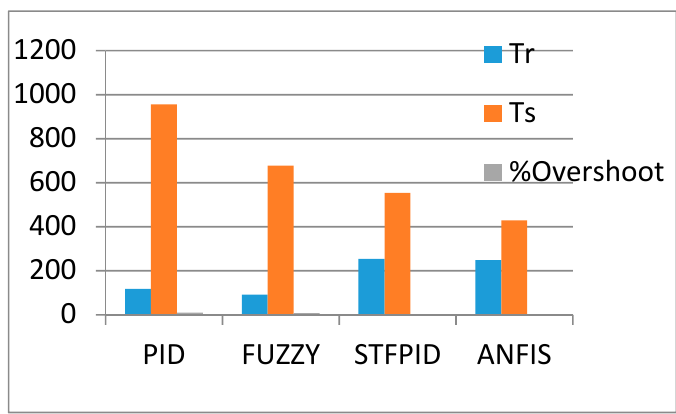
Figure 24. Bar chart of the heading plane control.